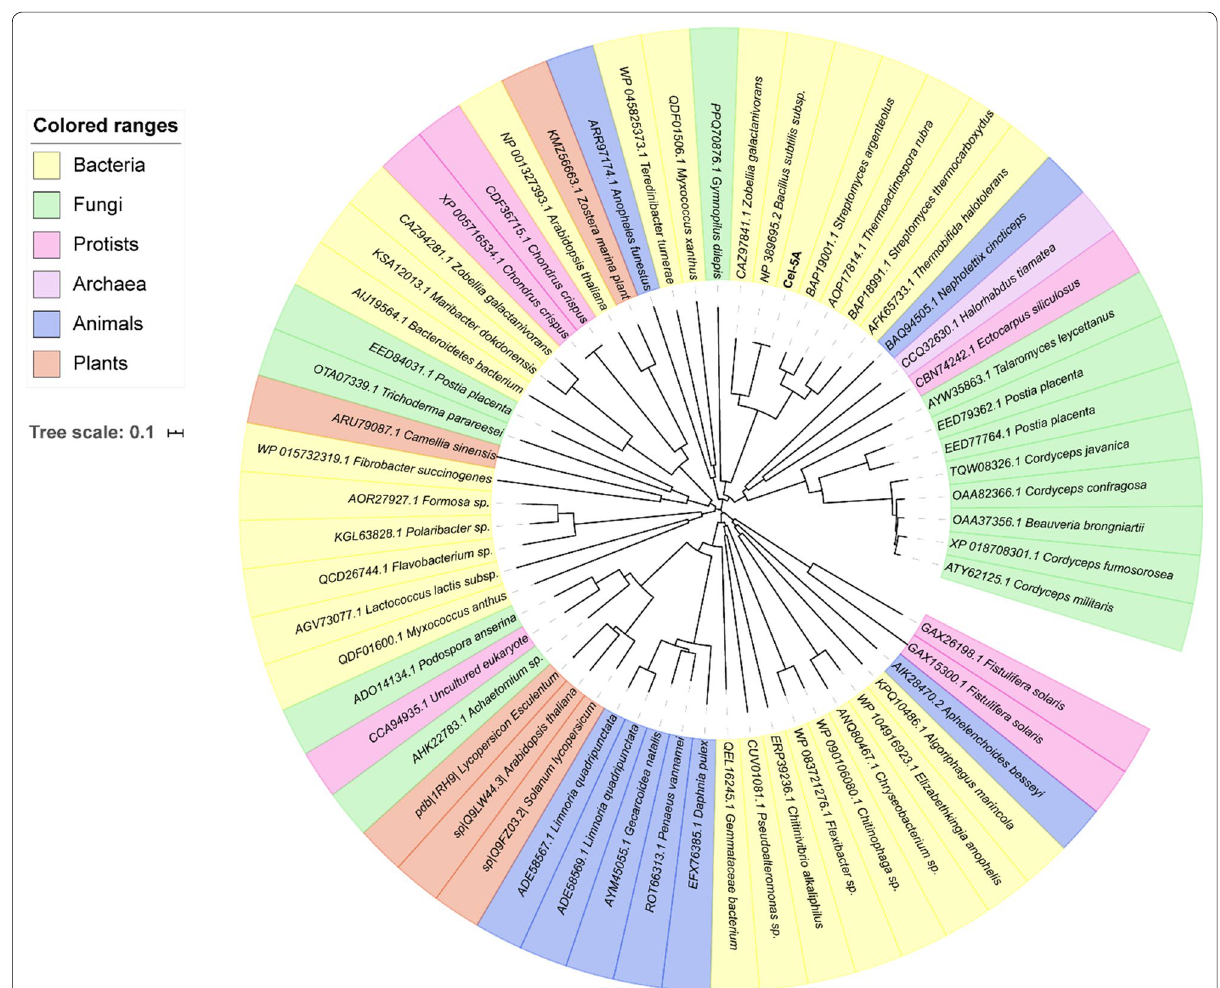
Fig. 3 A neighbor-joining phylogenetic tree of the GH5 family cellulase of different species. Only the access number and species name are shown. Different colors represent different species: yellow for bacteria, green for fungi, pink for protists, purple for archaea, blue for animals, and red for